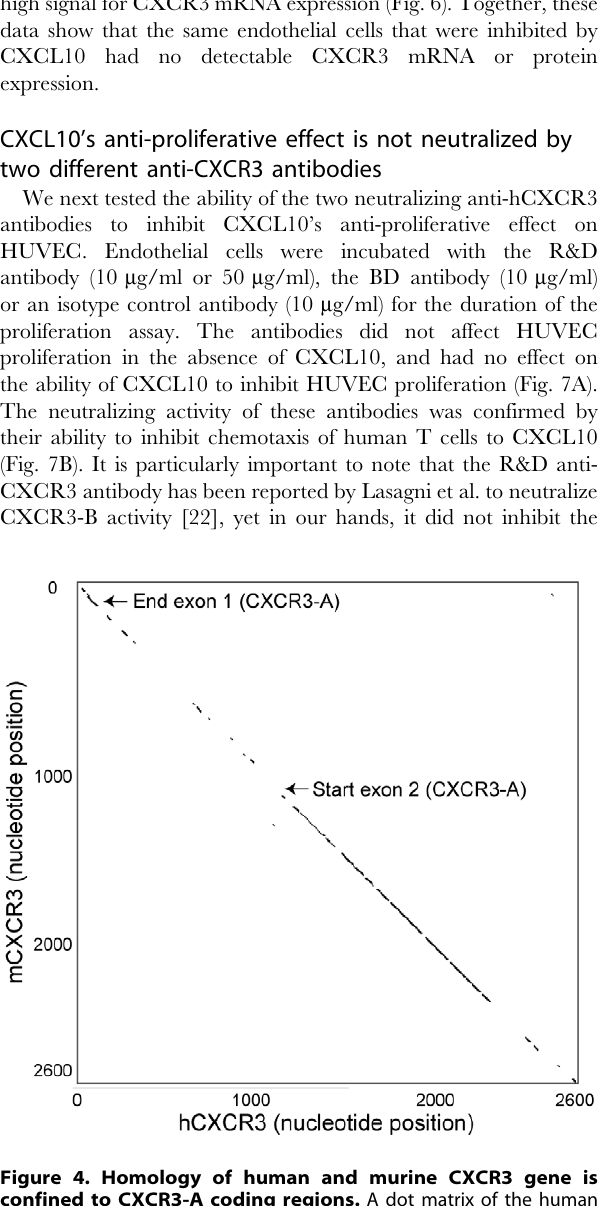
Figure 3. Alternative splice variant CXCR3-B does not exist in mice. A) human and B) murine CXCR3 schematic (top) and nucleotide sequence (bottom). The genomic/unspliced and cDNA are shown for CXCR3-A and B. Thick bars represent translated exons, thin bars untranslated exons, and thin lines introns. Regions common to both CXCR3-A and B are represented in black, regions that are specific for CXCR3-B in light grey. The 5 9 region that is translated for CXCR3-A, but untranslated for CXCR3-A is shown in dark grey. CXCR3-A and CXCR3-B splice donor site is indicated in green, CXCR3-A splice acceptor site in orange, proposed human CXCR3-B splice acceptor site in cyan. Initiating ATG codon for CXCR3-A is indicated in red, and potential initiating ATG codons for CXCR3-B in yellow, with the proposed CXCR3-B ATG underlined. For human CXCR3, the primer pairs used for detecting CXCR3-A [1F (forward) and 1R (reverse)] and CXCR3-B (2F and 2R) are indicated in the schematic. For murine CXCR3-B, nucleotide sequence position 912–1112 was translated to assess whether CXCR3-B exists in mice using the Expasy Proteomics server (http://www.expasy.org/ tools/dna.html). Frame 1 is in-frame with the remaining 3 9 sequence, but a stop codon would terminate any possible murine CXCR3-B.